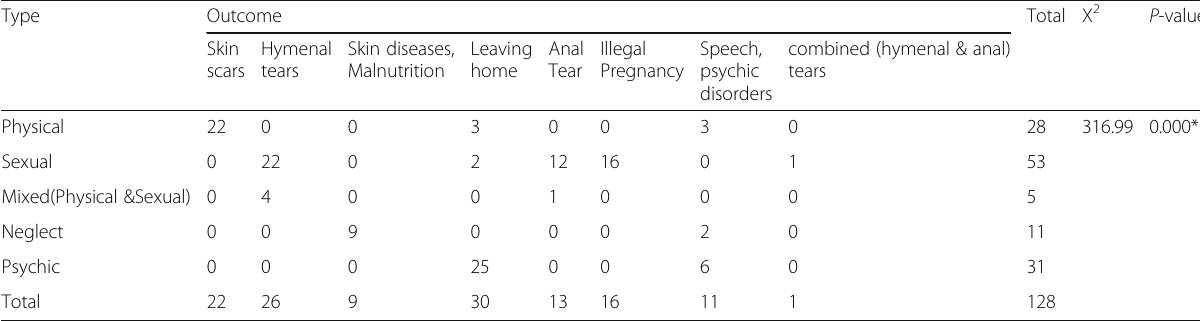
Table 8 Relation between type of violence and outcome among the studied cases